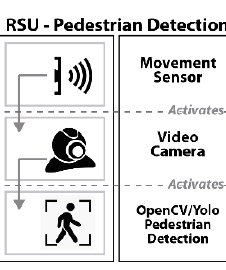
Figure 3. Road network infrastructure (RSU) Pedestrian Detection module.